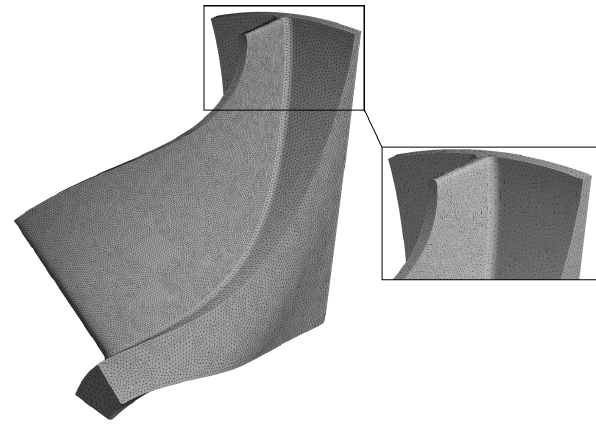
Figure 12: Mesh of the disc fragment